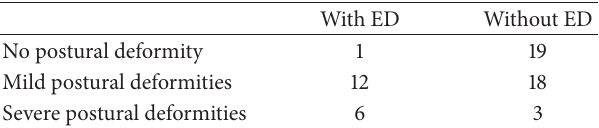
Table 3: Severity of postural deformities in PD patients with and without